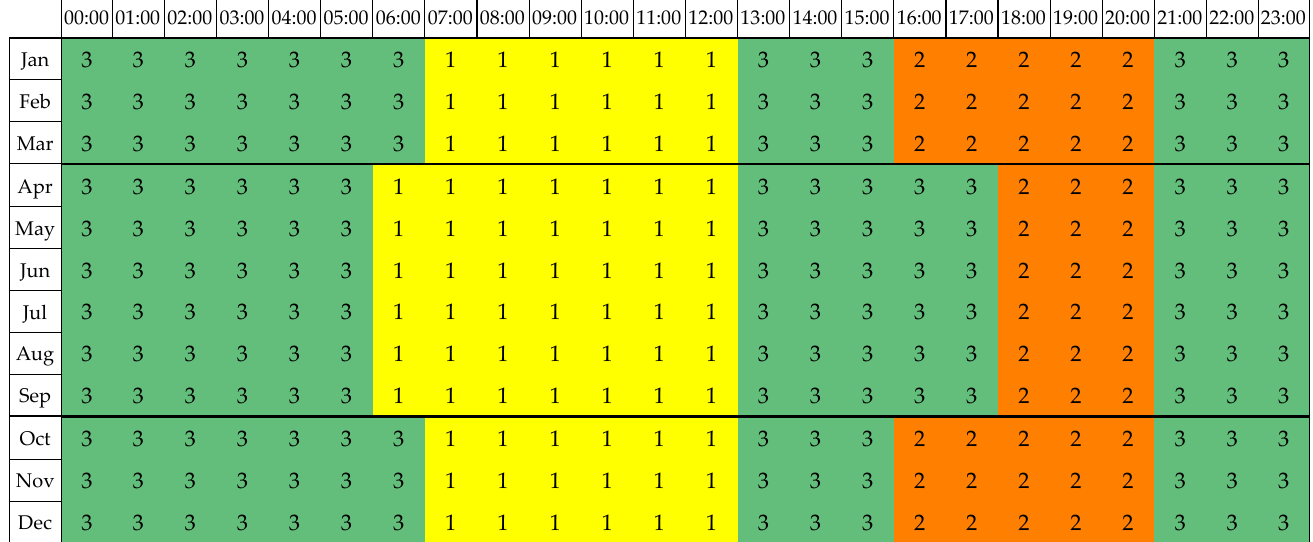
Table 1. Distribution of time zones in the B23 tariff group for individual months in UTC+1 time. Yellow background with 1 is zone S1; red background with 2 is zone S2; green background with 3 is zone S3.